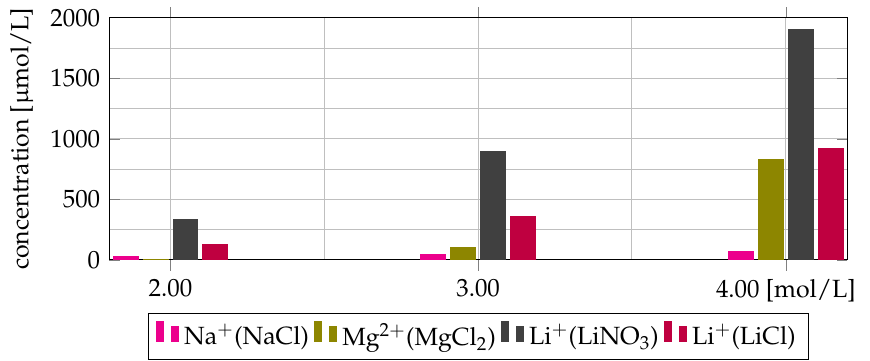
Figure 9. Effect of salting out agent and its concentration in the aqueous phase on the co-extraction of Na + , Mg 2 + , Li + .